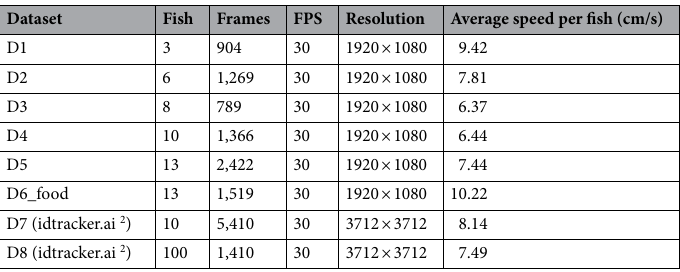
Table 1. List of videos used for zebrafish tracking. FPS frames per